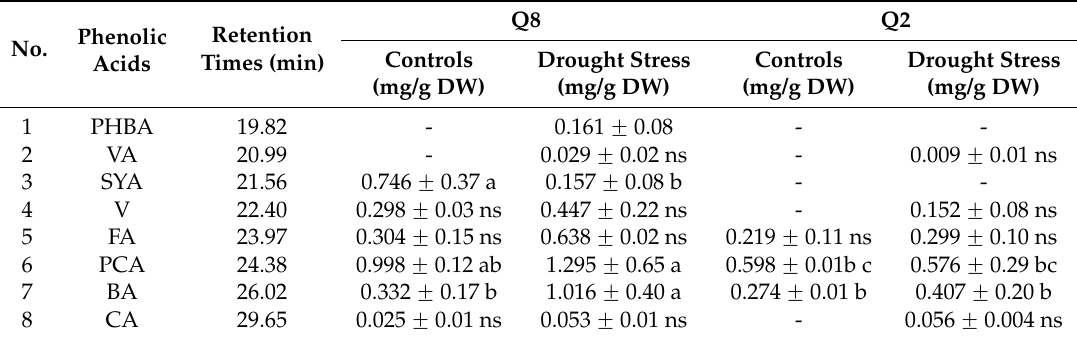
Table 4. Contents of phenolic acids in Q8 and Q2 determined by